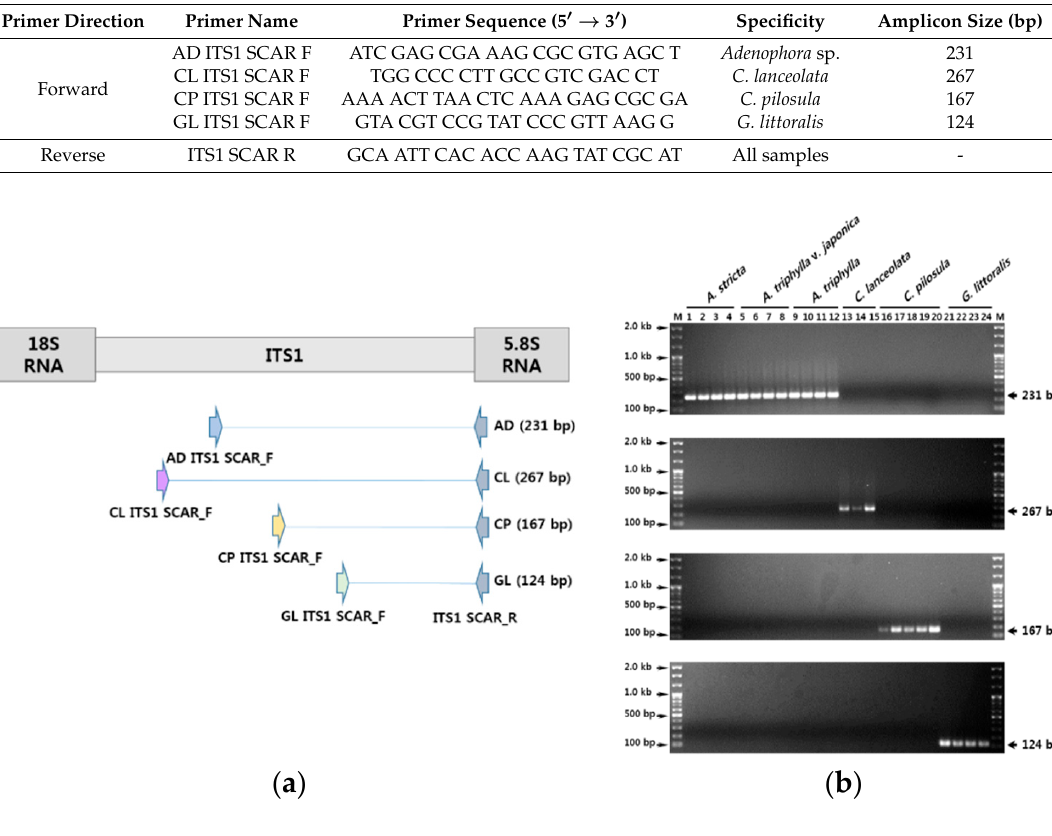
Figure 2. Development of species-specific SCAR markers based on inter-species sequence variability. ( a ) Schematic diagram of primer position and SCAR amplicon sizes; and ( b ) the verification of primer specificity for Adenophorae Radix, Codonopsis Lanceolatae Radix, Codonopsis Pilosulae Radix, and Glehniae Radix. The numbers 1–24 correspond to those listed in Table 1, in the ‘Lane in gel’ column. The precise lengths of DNA fragments are indicated to the right side of the gel images. M represents the 100 bp DNA ladder. Table 3. Sequences of the ITS1-SCAR primers and their specificity, amplicon sequence, and amplicon size.